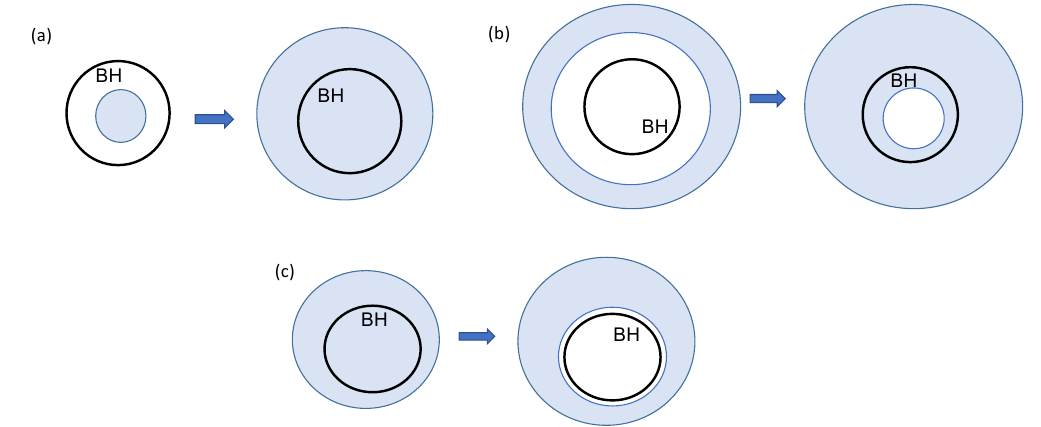
Figure 10 . Evolution of a black hole and the bath surrounding it, with the region inside the black circle representing the degrees of freedom of the black hole, and the region outside representing those of the bath. The shaded region denotes the support of an operator. (a) During evolution, the operators making up the density operator of a black hole can “leak” outside the black hole. (b) Bath operators can “fall” into the black hole. (c) Operators with support in the black hole region can also “jump” outside the black hole, forming a void which includes the black